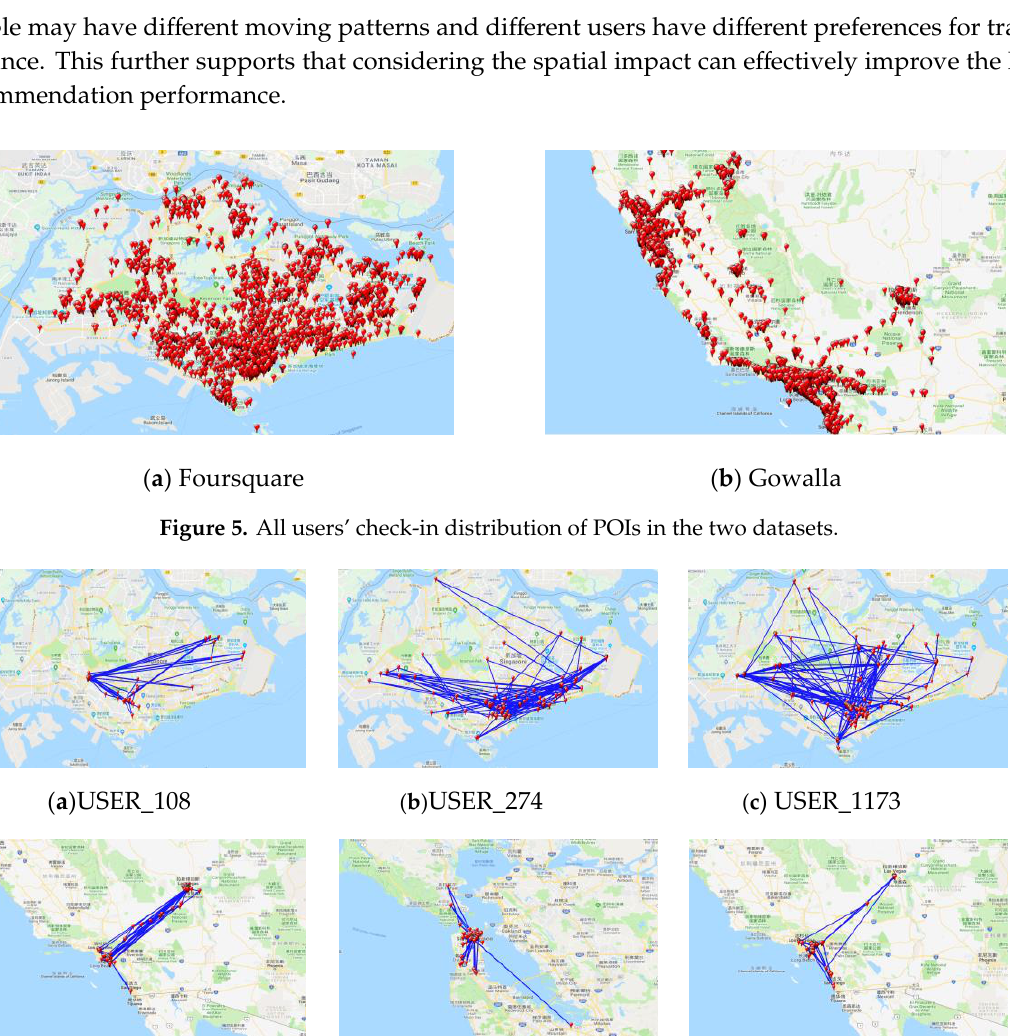
Table 2. Basic statistics of Foursquare and Gowalla datasets.